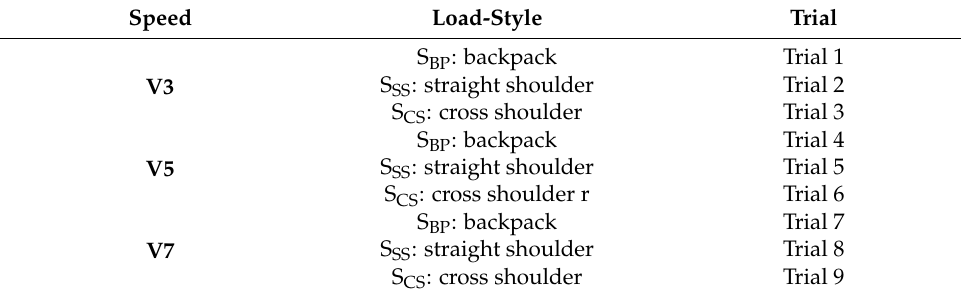
Table 1. Speed and load style information in nine